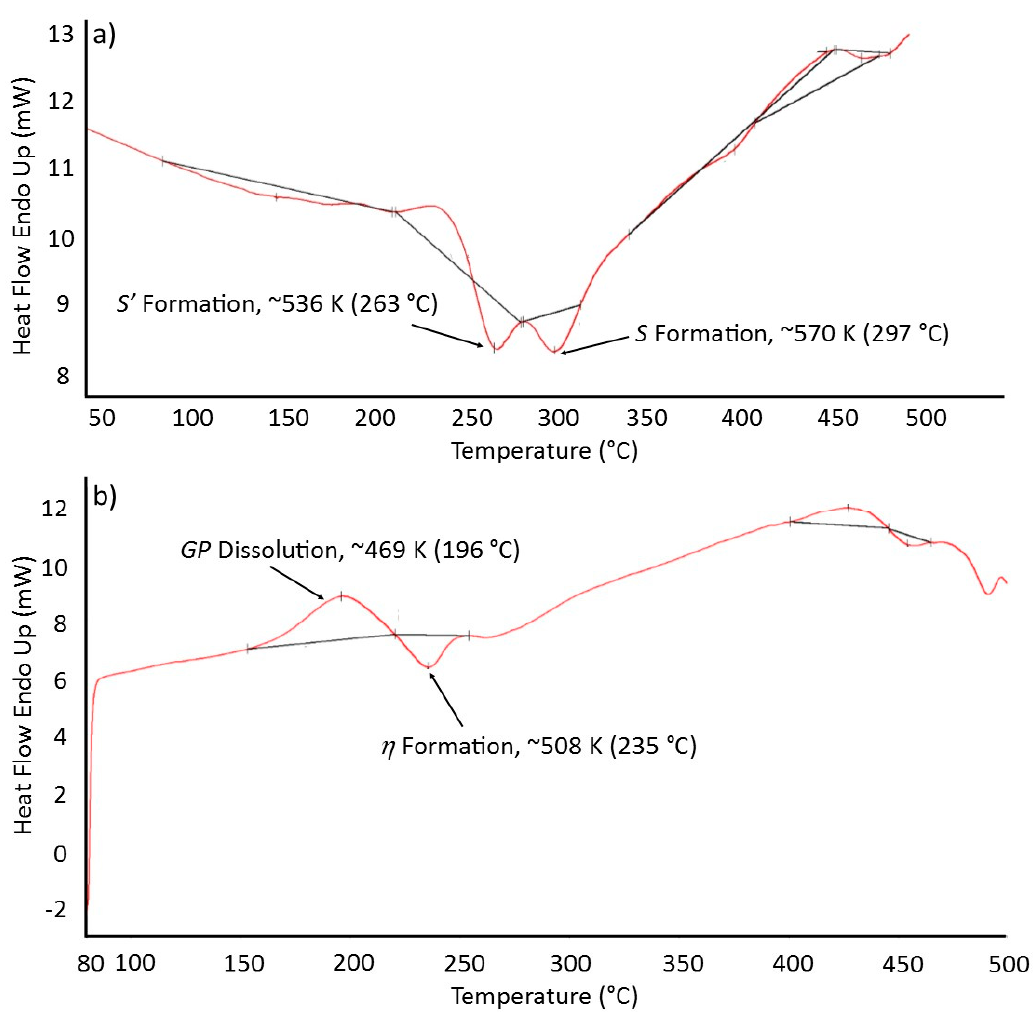
Figure 2. Differential scanning calorimetry (DSC) curves for workpiece materials with significant phase transformation peaks indicated: ( a ) 2017A and ( b ) 7075 [9].